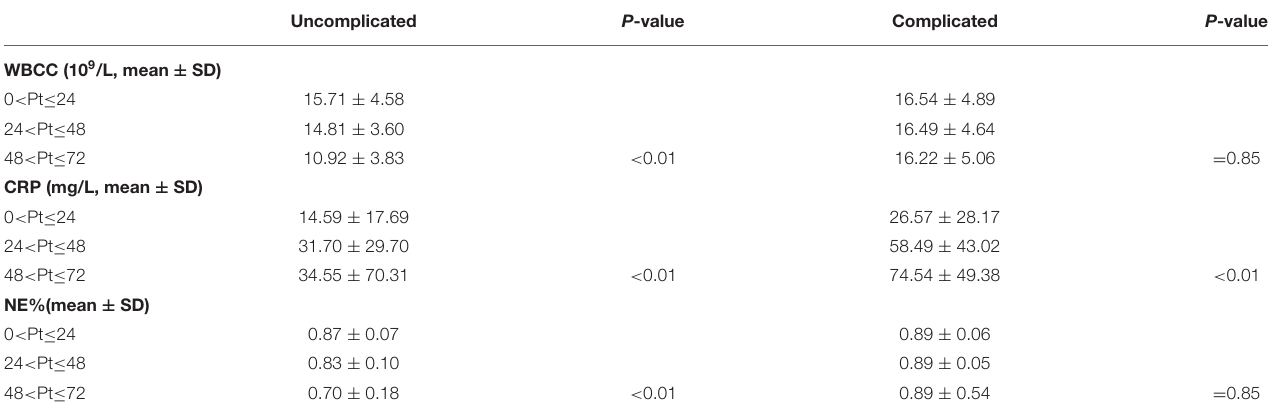
TABLE 6 | To analyze the relationship of WBCC, CRP, and NE% values in different periods of time in the same type of appendicitis. Uncomplicated P -value Complicated P